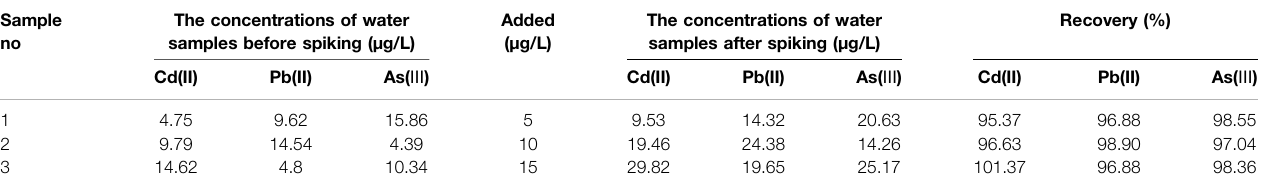
TABLE 2 | Results of multiplexed detection of Cd(II), Pb(II), and As( Ⅲ ) in simulated water samples. Sample The concentrations of water no samples before spiking ( μ